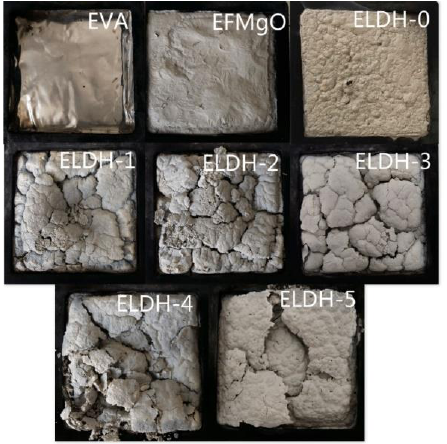
Figure 5. Photographs after cone calorimeter test.